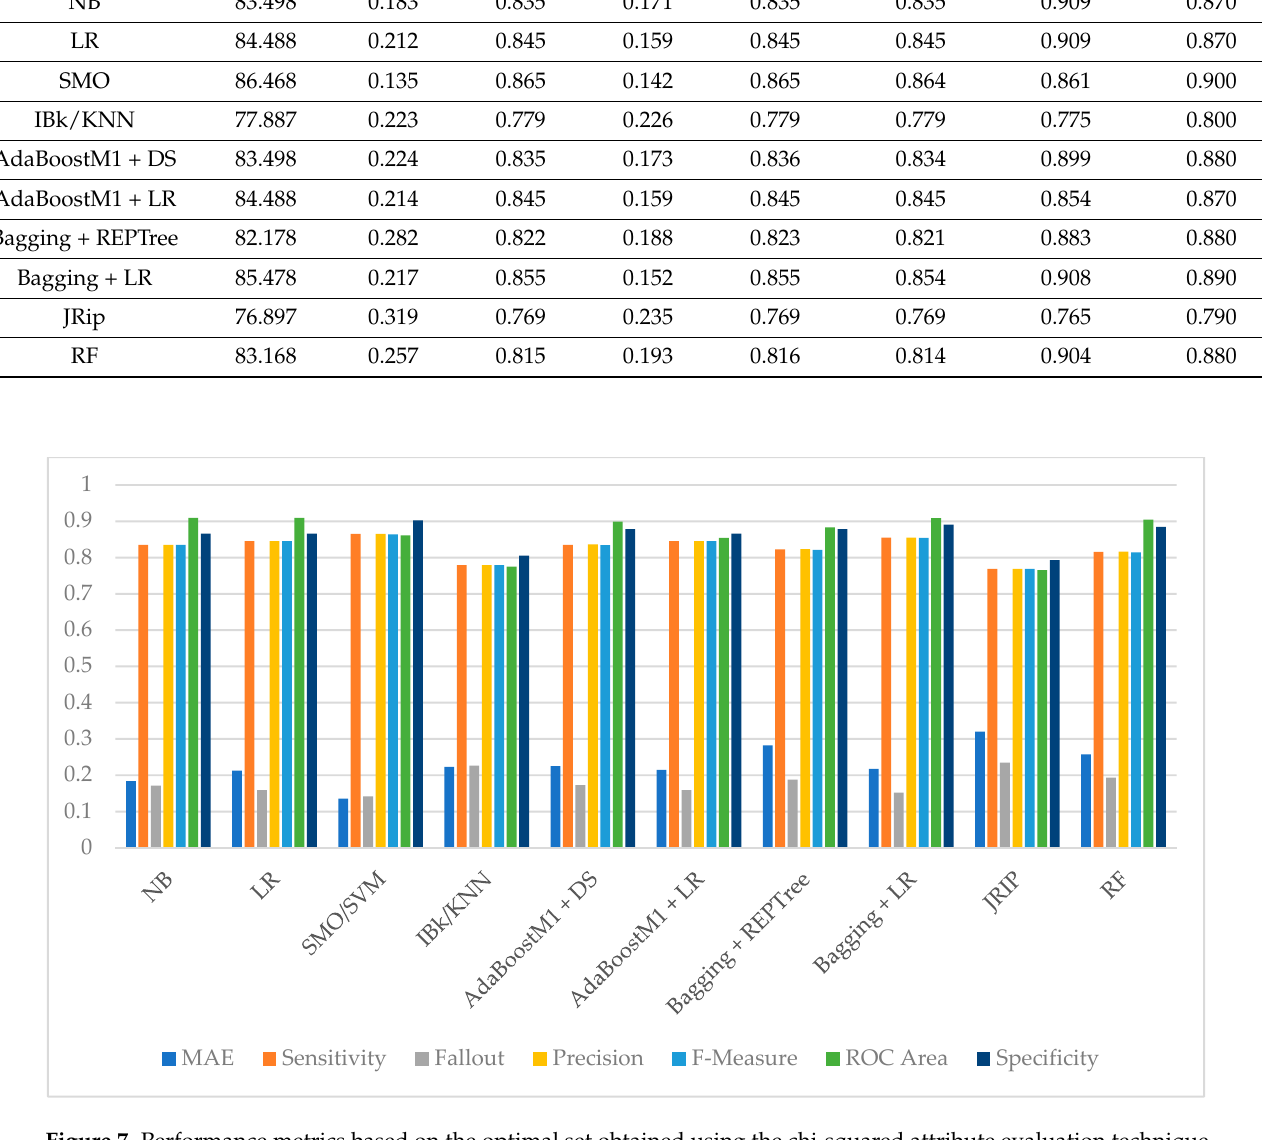
Figure 7. Performance metrics based on the optimal set obtained using the chi-squared attribute evaluation technique.